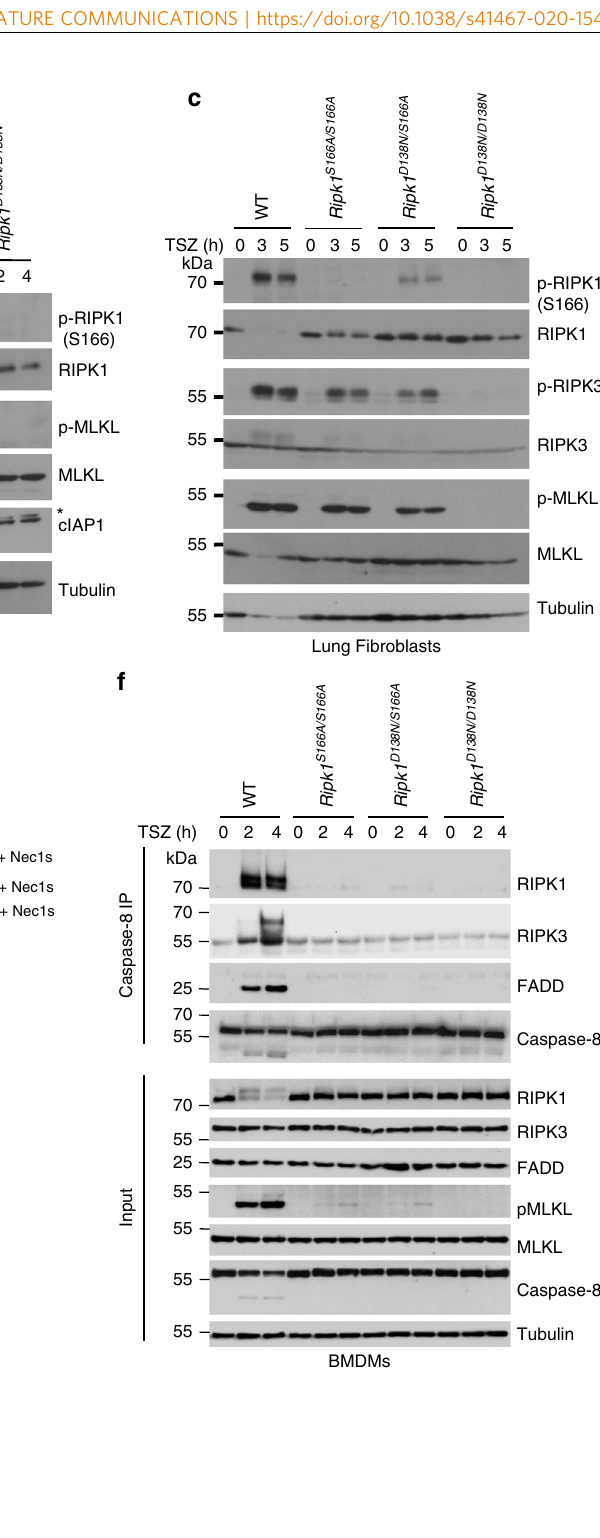
Histological analysis of tissue sections . Skin, colon and liver tissue samples from mice were fi xed overnight in 4% paraformaldehyde, embedded in paraf fi n, and cut in 3 – 5µm sections. For Immunohistochemistry staining, paraf fi n sections were